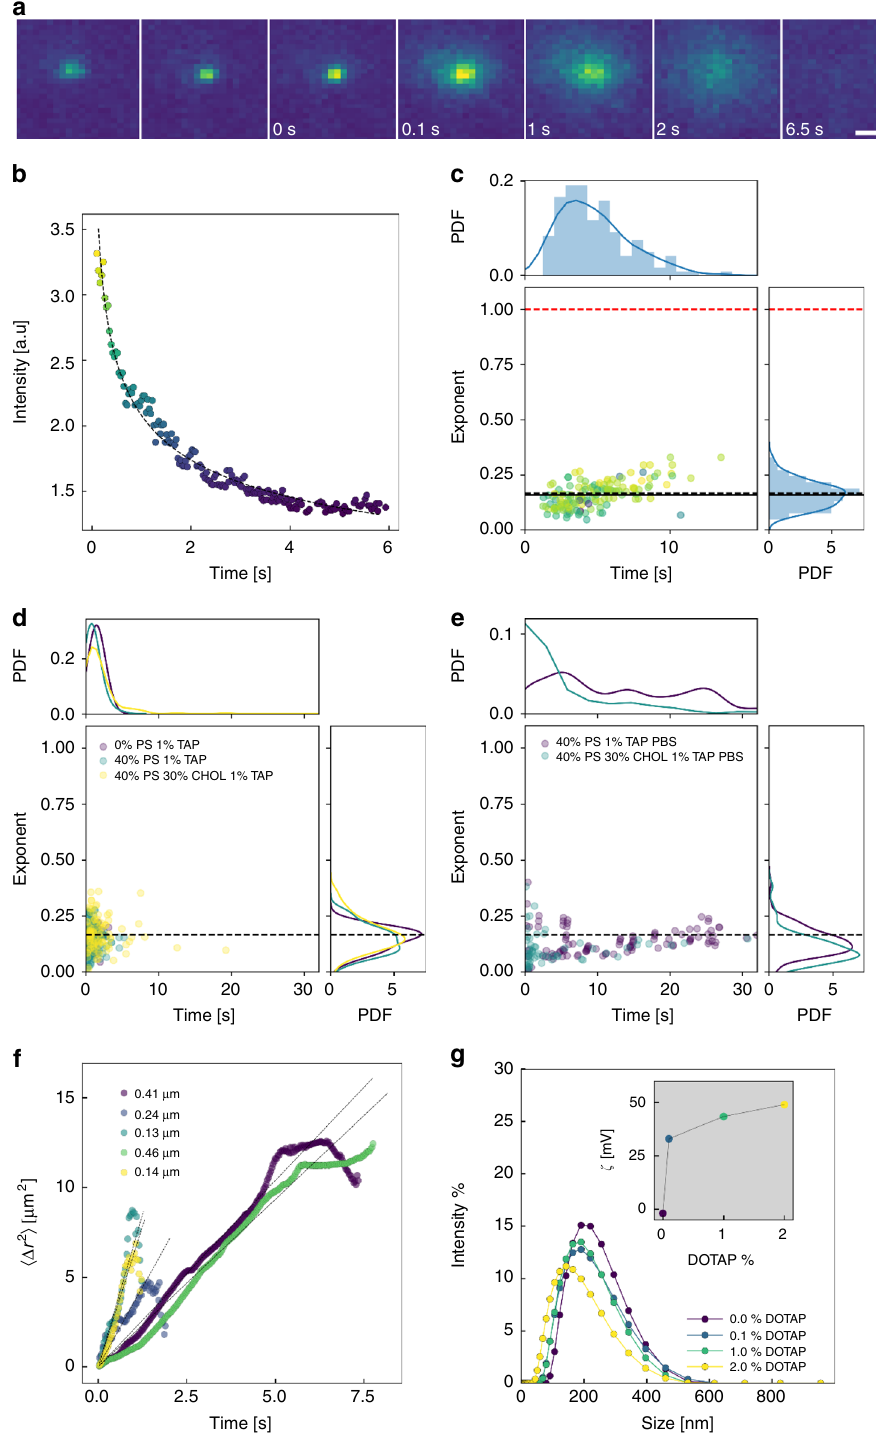
Fig. 3 Dynamic analysis of individual cubosome fusion. a TIRF snapshots of a single cubosome fusion event over the course of ~6 s. Scale bar = 1.5 µ m. b The corresponding plot of intensity with time during a single fusion event. The best fi t to I = at - n is shown by the dashed line; for this case a ~2, n ~0.23. c Plot and distribution of fusion time and fi tted exponent for many MO cubosome fusion events on a DOPC bilayer. The mean exponent, proposed 1/6 exponent and theoretical 2D diffusion exponent are shown by the solid black, dashed black and solid red lines, respectively. d Distribution of fusion time and fi tted exponent for 1% DOTAP cubosomes with 0% DOPS, 40% DOPS and 40% DOPS 30% CHOL membranes. e Distribution of fusion times and fi tted exponents for 1% DOTAP cubosomes with 40% DOPS and 40% DOPS 30% CHOL bilayers in PBS. f Measured mean-squared displacement for cubosomes above SLB. The dashed line is best fi t against < r 2 > = 2 d Dt. The determined particle sizes from each slope are shown in the legend. g DLS particle size distribution for cubosomes with increasing DOTAP composition. The corresponding zeta potential ( ζ ) measurements are shown in the